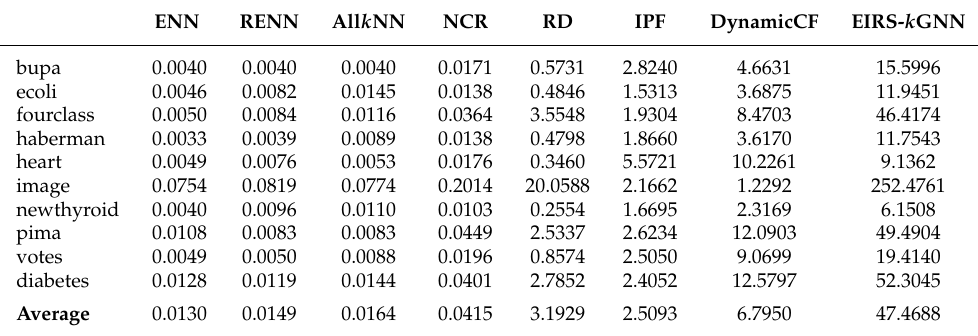
Table 4. Average running time (s) comparison. ENN RENN All k